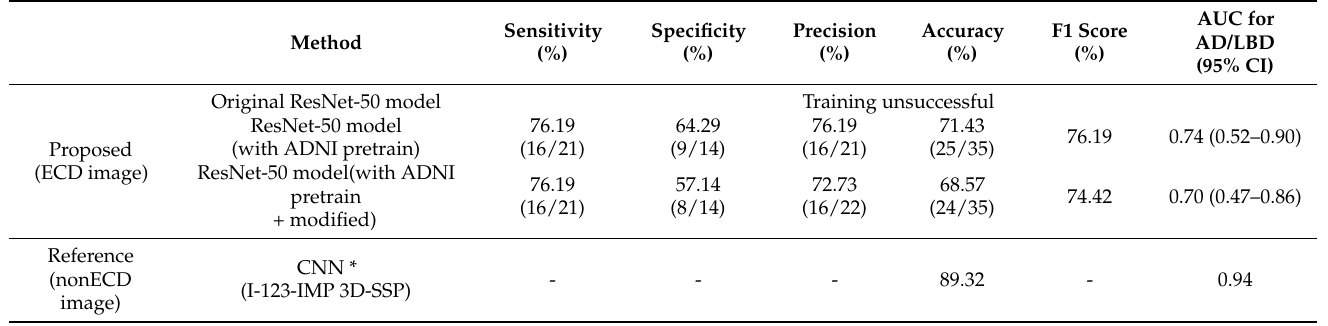
Table 6. Comparison of the training performance of ECD data sets in various models for distinguishing between AD and